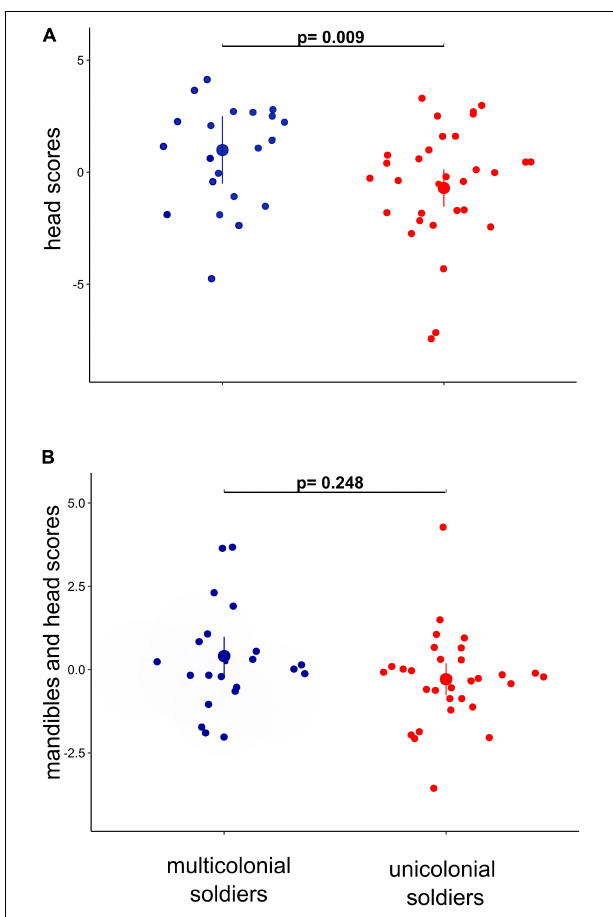
FIGURE 2 | Soldiers’ head (A) and mandible/head (B) components among soldiers from multicolonial and unicolonial substrates. In the plot, the modeled means are represented by large circles, bars are the modeled 95% confidence intervals, and the model-adjusted individual response values are represented by the small dots. Metric scores were obtained from PCA of body size metrics. P -values indicate significance at p <